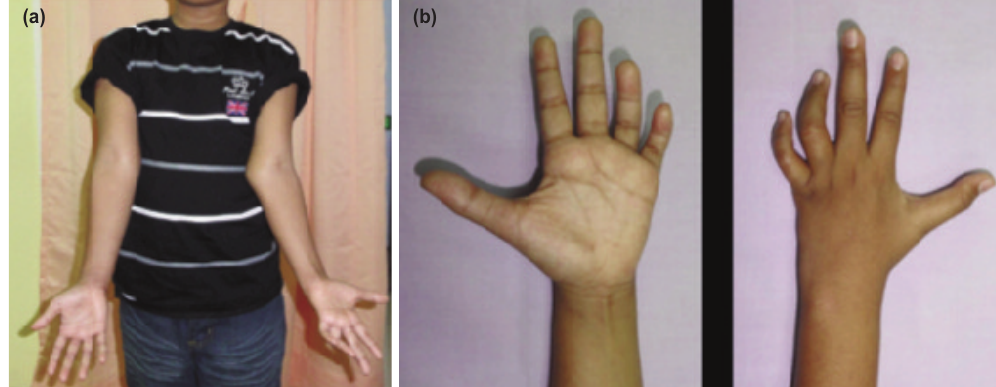
Pre-operative appearance of the left elbow and left hand. (a) Left cubitus valgus with prominent medial epicondyle. Fig. 1: (b) Left ulnar claw hand with wasting of the intrinsic muscles.